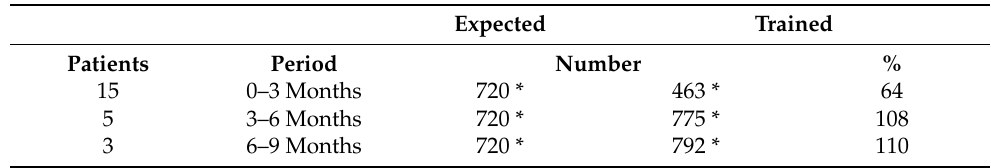
Table 4. Patient adherence shown as the number and percentage of training time performed and patient satisfaction from baseline to follow-up after 9 months.